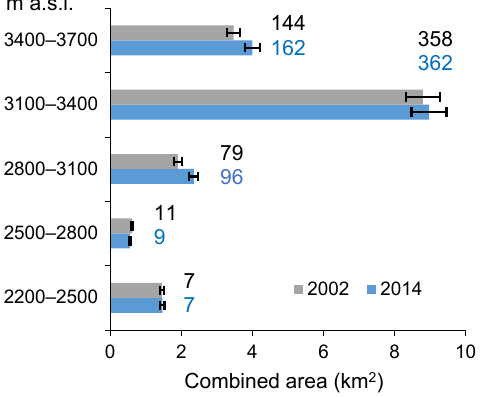
Figure 7. Lake count (numbers) and combined area (bars) by el- evation (ma.s.l.). The black bars represent the uncertainty of area